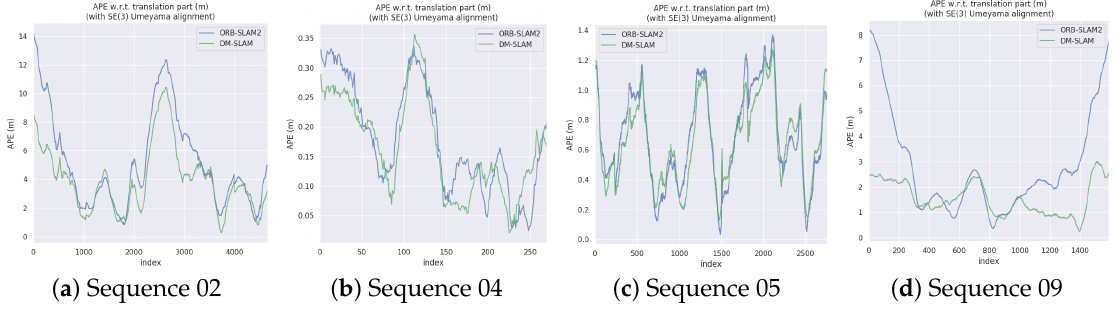
Figure 11. ( a – d ) Absolute pose error (APE) of DM-SLAM and ORB-SLAM2 for the 02, 04, 05, and 09 sequences of the KITTI